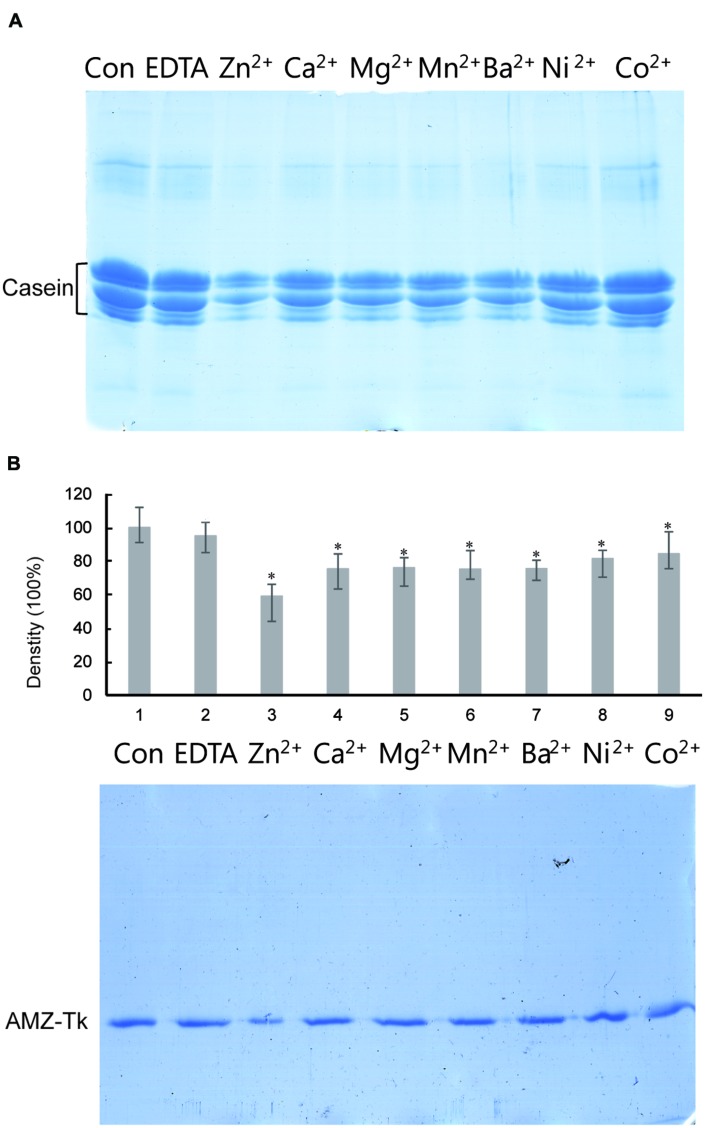
Degradation of casein by AMZ-tk and self-cleavage activity of purified AMZ-tk analyzed by SDS-PAGE. (A) Degradation of casein by AMZ-tk. Purified AMZ-tk was incubated with casein at 55°C in the presence of 0.08 mM divalent ions or 5 mM EDTA for 30 min. Casein alone was used as control. Samples were analyzed using 12% SDS-PAGE and Coomassie Brilliant Blue staining. (B) Self-cleavage of purified AMZ-tk. Purified AMZ-tk was incubated at 55°C in the presence of 0.08 mM divalent ions or 5 mM EDTA for 30 min. Fresh purified protein was used as control. Samples were analyzed using 12% SDS-PAGE and Coomassie Brilliant Blue staining. The upper panel shows the density of protein bands. ∗p < 0.05 compared with fresh purified protein.